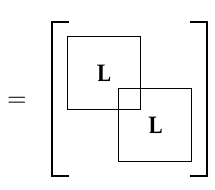
Figure 3. Laplacian matrix of a periodic graph G P with P =